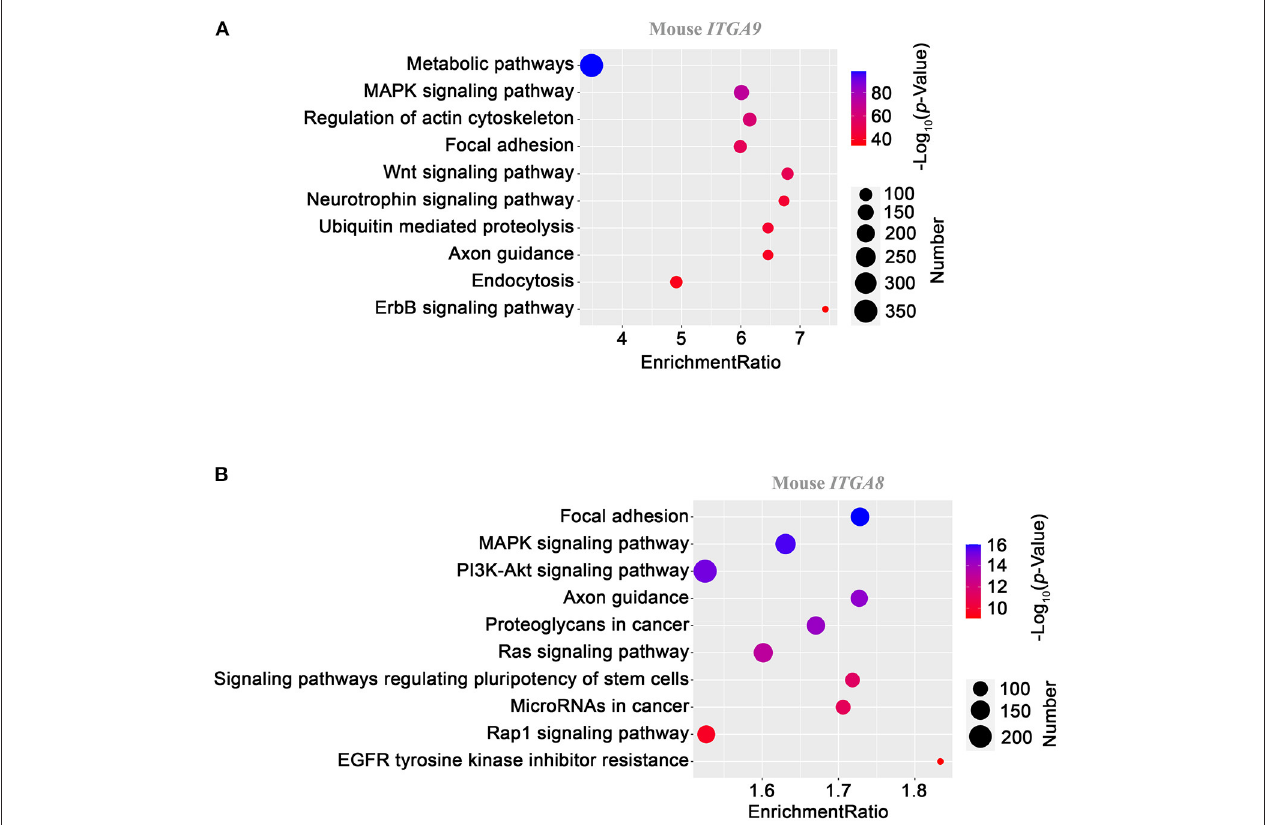
FIGURE 4 | KEGG pathway enrichment analysis on ITGA9 (A) and ITGA8 (B) using gene correlation data from mouse aortas. Gene set enrichment analysis was performed as described in the Methods section. The dot size presents the number of enriched genes with the indicated pathway, and the dot color codes the level of –log 10 of the p value. The enrichment ratio is defined as the number of observed genes divided by the number of expected genes in a KEGG category.